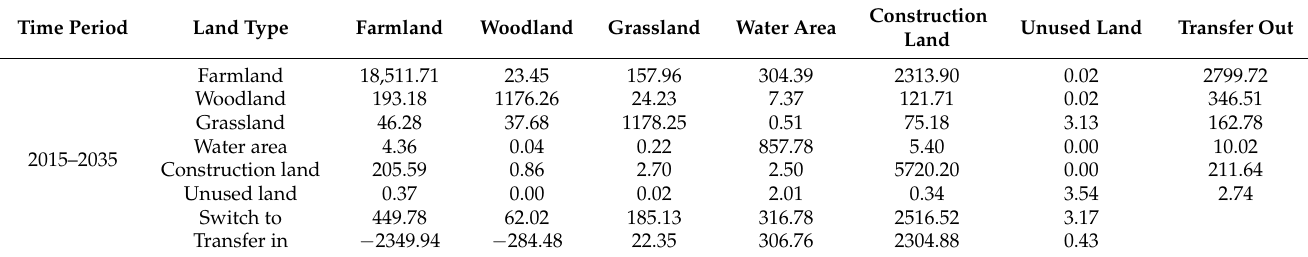
Table 7. Transfer matrix of land use area from 2015 to 2035 (km 2 ).